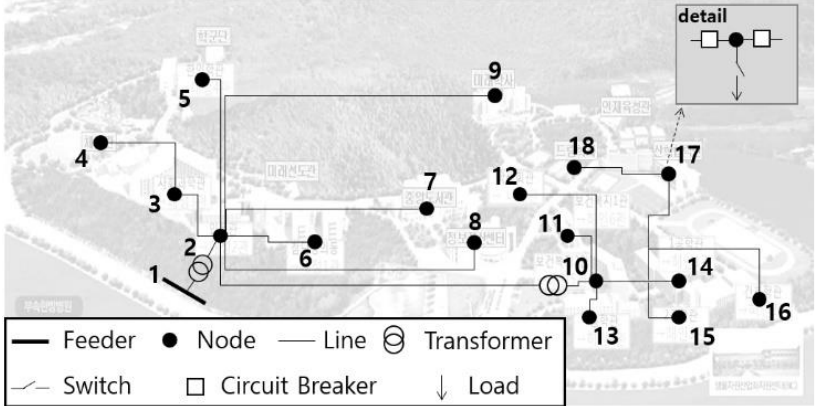
Figure 7. System configuration at D-university.